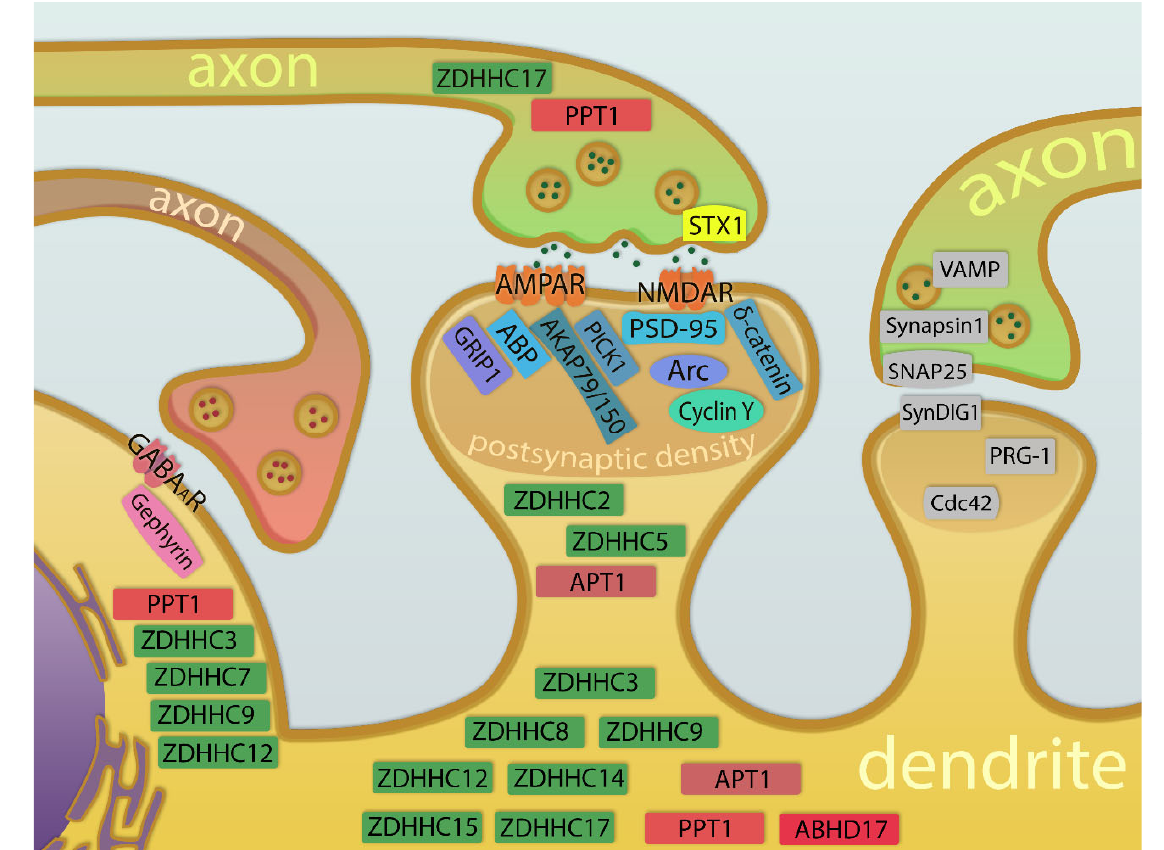
Figure 2. Schematic illustration of the proteins and enzymes of the palmitoylation machinery men- tioned in this review in the context of function and plasticity of inhibitory and excitatory synapse. Synaptic proteins in the inhibitory (left) and excitatory (middle) synapses are symbolically depicted, together with palmitoyltransferases (green) and depalmitoylating enzymes (red). The right panel shows proteins (gray) that undergo neuronal activity-dependent palmitoylation and could potentially be involved in the regulation of the function or plasticity of the excitatory synapses (puta- tive candidates not yet confirmed with functional experiments). APT1, acyl-protein thioesterase 1; PPT1, palmitoyl-protein thioesterase 1; ABHD17, alpha/beta hydrolase domain-containing proteins 17; ZDHHC, zinc finger DHHCs; GABA A R, GABA A receptor; AMPAR, AMPA receptor; NMDAR, NMDA receptor; PSD-95, Postsynaptic density protein 95; PICK1, protein interacting with C-kinase; AKAP79/150, A-kinase anchoring protein 79/150; ABP, AMPA receptor binding protein; GRIP1, glutamate receptor interacting protein-1; Arc, activity-regulated cytoskeletal-associated pro- tein; VAMP, vesicle-associated membrane protein; SNAP25, synaptosomal-associated protein 25; SynDIG1, synapse differentiation Inducing 1 protein; PRG-1, plasticity-related gene 1 protein; Cdc42, cell division control protein 42